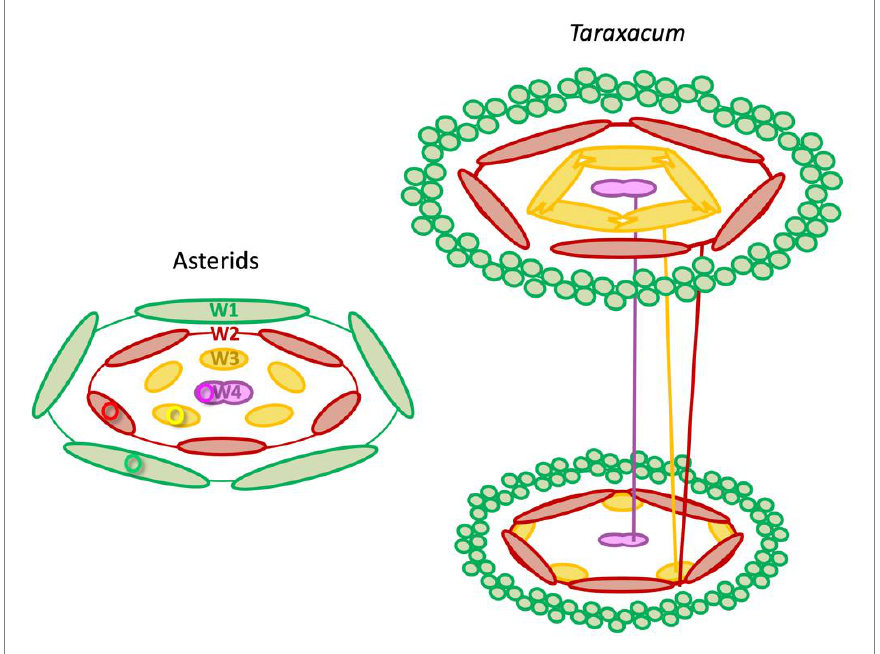
Figure 3. Floral diagram of the Asteridae versus dandelion. ( Left ) The floral diagram representative of the Asteridae, modified from [25], showing the four floral whorls (W1 – W4) and pentamerous bauplan, with five sepals (green), five petals (red), five stamens (yellow), and two carpels (pink), with one of each vascular bundle indicated (coloured circles). ( Right ) Floral diagrams representative of the upper and lower part of the dandelion floret, showing deviations from the common diagram in three respects: (1) in the outer floral whorl, the five sepals are absent, instead numerous pappus parts are found; (2) a central or major bundle to the pappus is lacking; (3) the median bundles to the petals are undetected, whereas major lateral bundles are present in the fusion zones between adjacent petals instead; one of each vascular bundle indicated (coloured lines). In the lower part of the dandelion floret, the petals are fused to a tube and the stamen filaments associate with the fusion zones. In the upper part of the floret, one of the fusion zones between petals is lifted, where the corolla forms a ligule and anthers form a continuous ring (see Figure 1G).